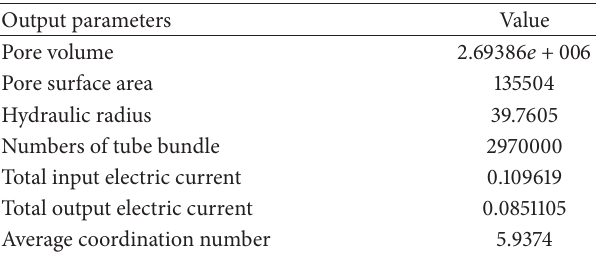
Table 4: Program output parameters.